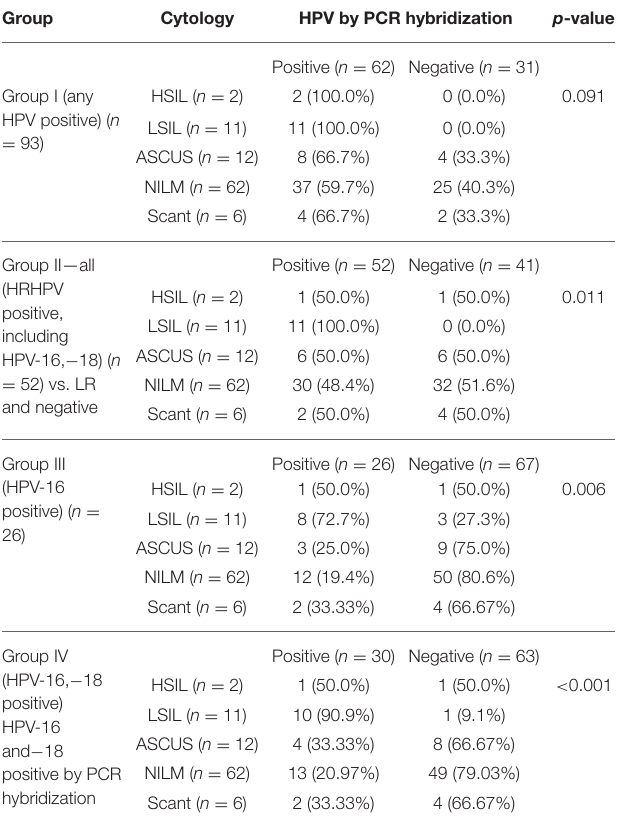
TABLE 2 | HPV-16 viral load, cytology, and CD4 counts ( n = 18). S.no.